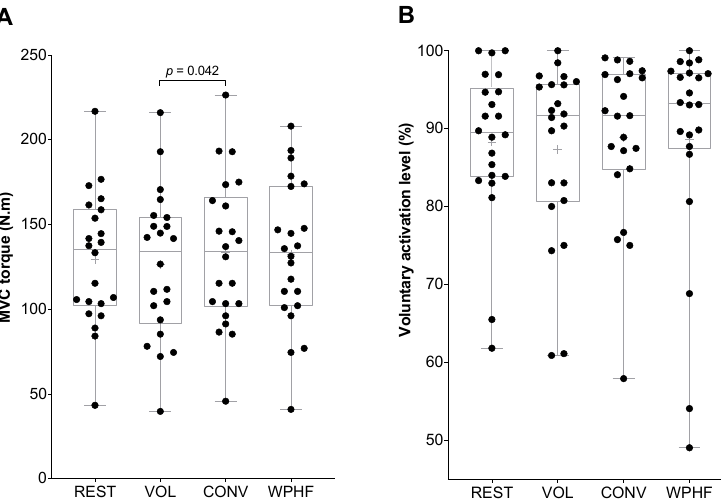
Figure 2. Right leg plantar flexor ( A ) MVC torque while the left plantar flexors were at rest (REST), contracted at 10% MVC torque (VOL) or stimulated with conventional NMES (CONV) or wide- pulse high-frequency NMES (WPHF) and ( B ) right leg plantar flexor voluntary activation level in REST, VOL, CONV, and WPHF conditions. Individual data are presented as dots on a boxplot. The horizontal lines on the box represent the 75th, 50th (median) and 25th percentiles and the cross represents the mean. The whiskers extend to the maximum and minimum values. Only the p -value of a significant post-hoc comparison is shown on the graph.